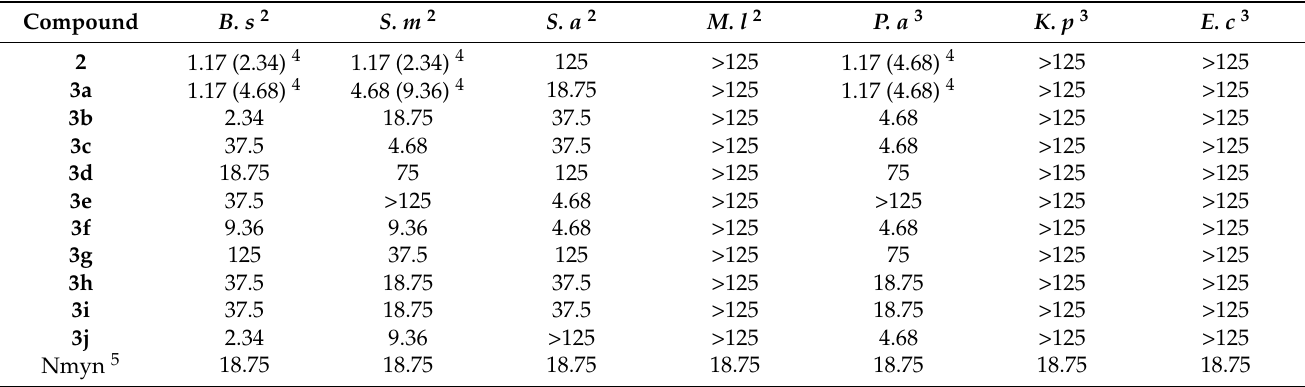
Table 1. Antibacterial activities of oxazolidinone-sulfonamide conjugates ( 3a–j ) 1 .